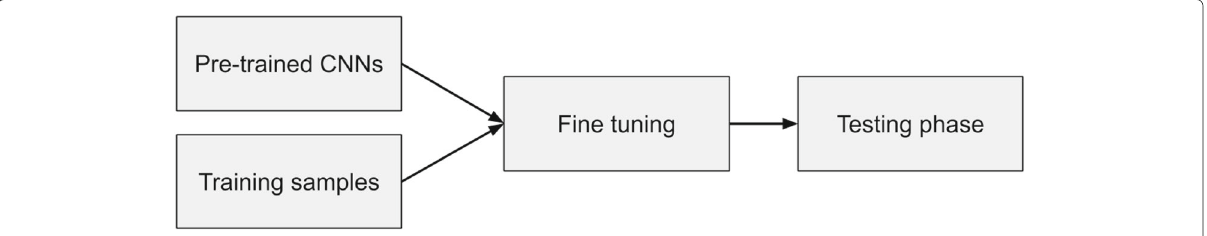
CONV/FC layers. The CONV layers are extremely homogeneous and use very small ( 3 × 3 ) convolution filters with a POOL layer inserted after every two or three CONV layers (instead after each CONV layer as in AlexNet). The two best-performing VGG models (Vgg-16 and Vgg-19), with 16 and 19 weight layers, respectively, are available as pretrained